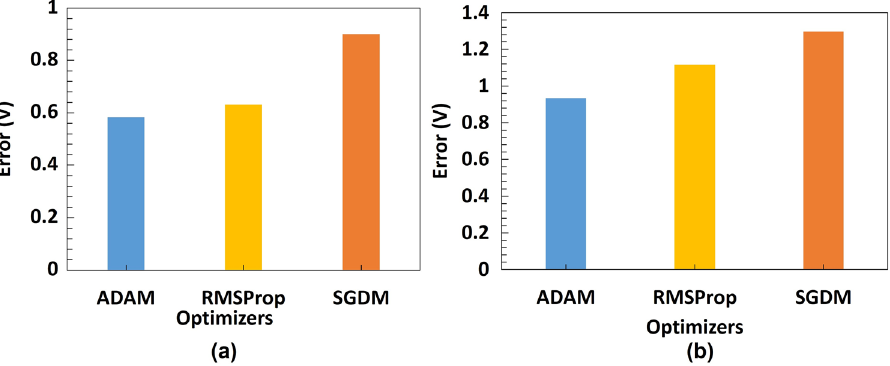
Figure 11. Sum of RMSE by Optimizer on ( a ) Yeast Cell Dataset ( b ) PS Microbead